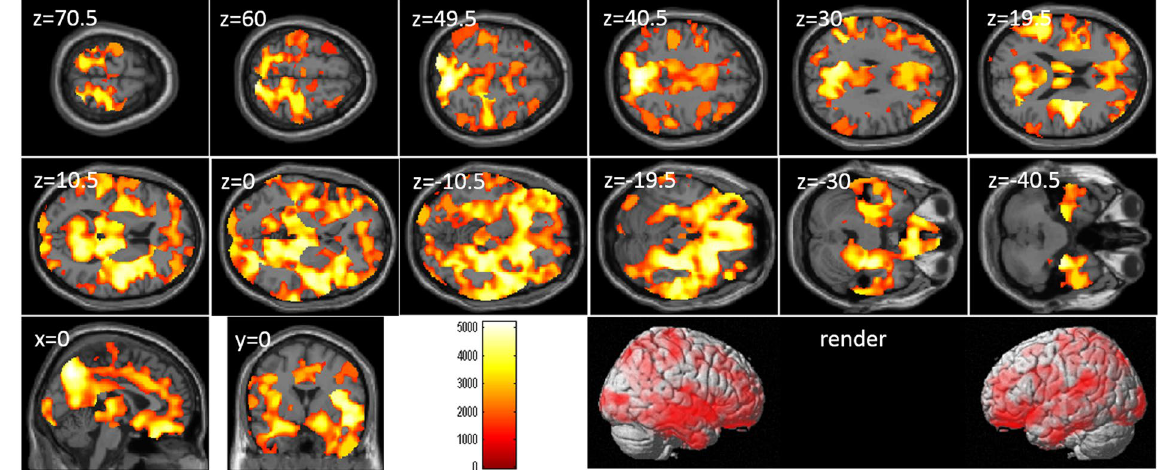
Figure 5. Relationships between complex processing speed involving reasoning and rGMV. Figures show areas of significant negative correlation between TBIT reasoning factor scores and rGMV by multiple regression analysis corrected for effects of age and sex. The results shown were obtained using a threshold of TFCE, P < 0.05 corrected (FWE) based on 5000 permutations. In section images, the color bar represents TFCE values. Significant positive correlations were found across the whole brain.